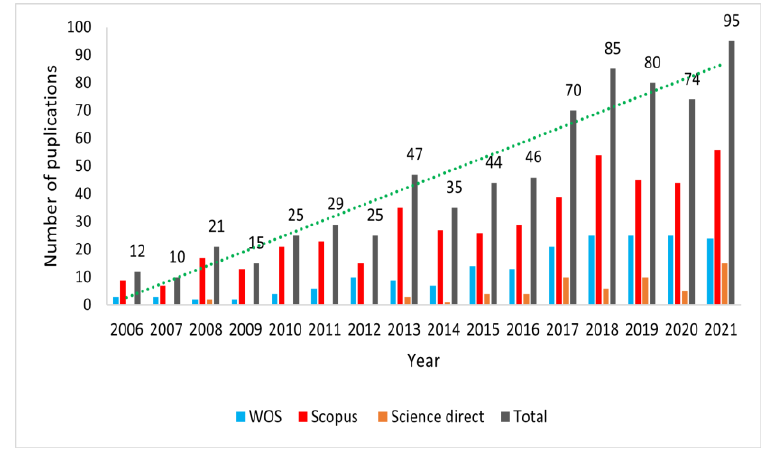
Figure 3. Yearly distribution of the raw collected publications.